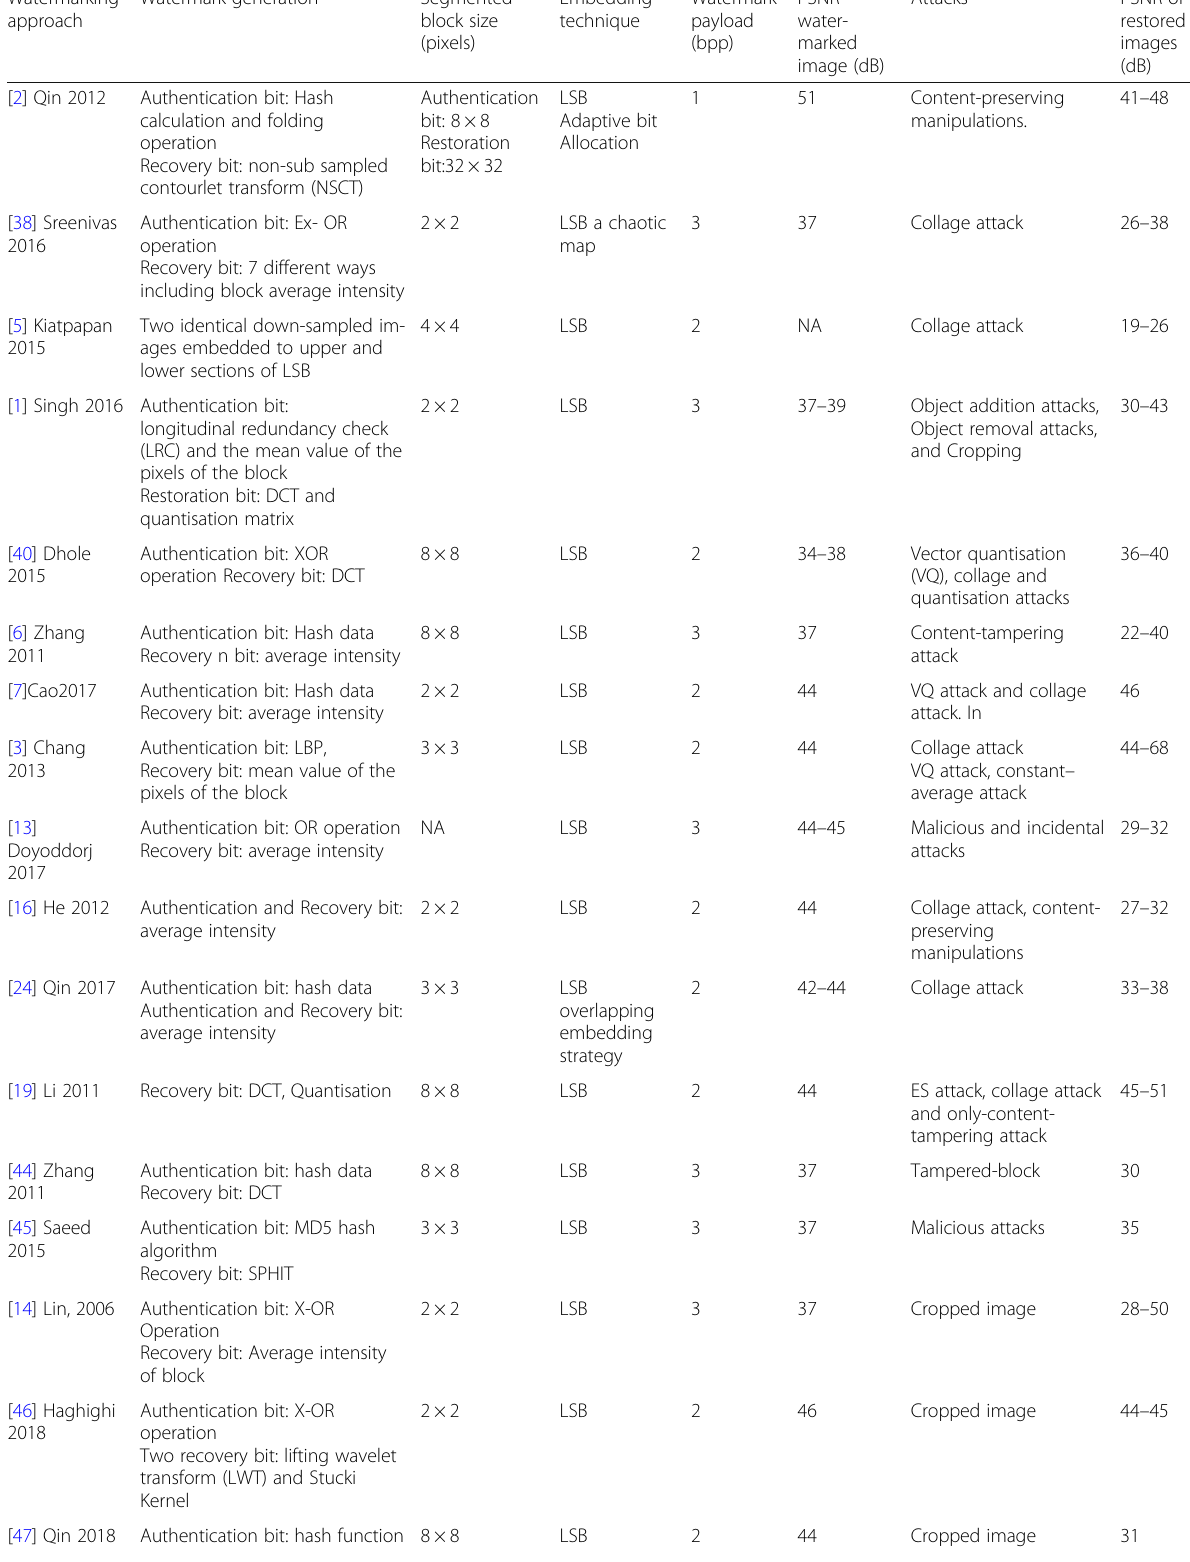
Table 2 Summary of some self-embedding fragile watermarking methods in the spatial domain Watermarking